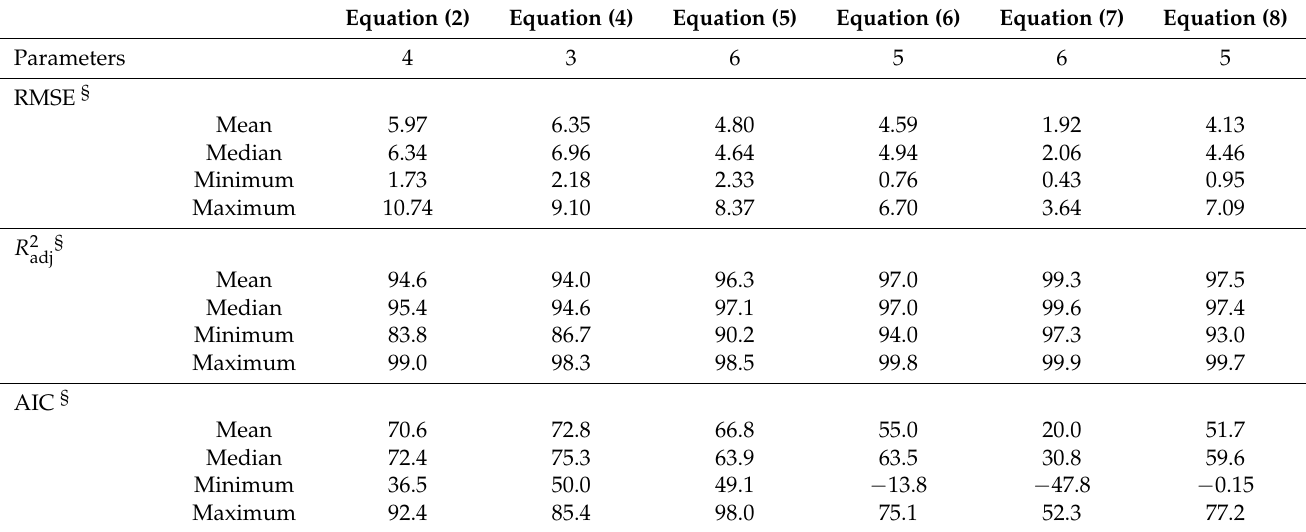
Figure 6. An example of fitting the simplified double Mitscherlich equation to biphasic gas production profiles generated using an equine fecal inoculum and a grass hay substrate by Murray et al. [18]. The figure shows the overall fit (solid line) and the two resolved components (red and blue broken lines). The first component starts very early in the run and approaches its asymptote, whilst the second starts much later. The dots represent observed data points. Table 2. Goodness-of-fit of the six equations (two monophasic [Equations (2) and (4)] and 4 biphasic [Equations (5)–(8)]) to 17 atypical average gas production profiles obtained in incubations using equine fecal